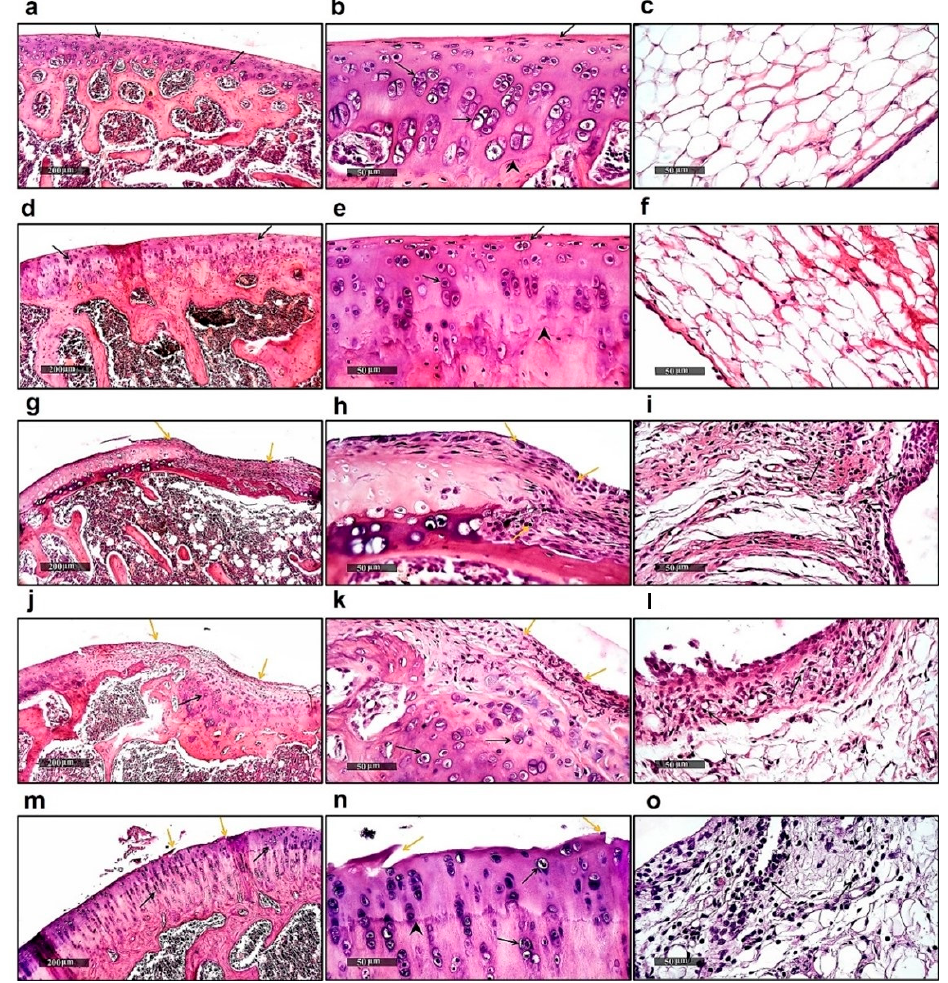
Figure 1. Histopathology. Photomicrographs of ( a – c ) knee joint samples of normal healthy rats showing well-organized intact chondrocytes inside lacuna (black arrow) in the presence of obvious demarcation between non-calcified and calcified zones (arrowhead); ( d – f ) knee joint sample of normal rats treated with dabigatran showing no anomalies; ( g – i ) knee joint samples of CFA-treated rats showing significant inflammatory cell infiltrates (yellow arrow) with a significant decrease in articular cartilage thickness; ( j – l ) knee joint samples of arthritic group treated with low dose of dabigatran showing minimized articular surface erosions and replacement with fibrous tissue (yellow arrow) with higher chondrogenic activity (black arrow); ( m – o ) knee joint samples of arthritic group treated with higher dose of dabigatran showing minor articular surface irregularities (yellow arrow), significant thickness recovery of articular cartilage (arrowhead), and the presence of mature chondrocytes all over articular surfaces (black